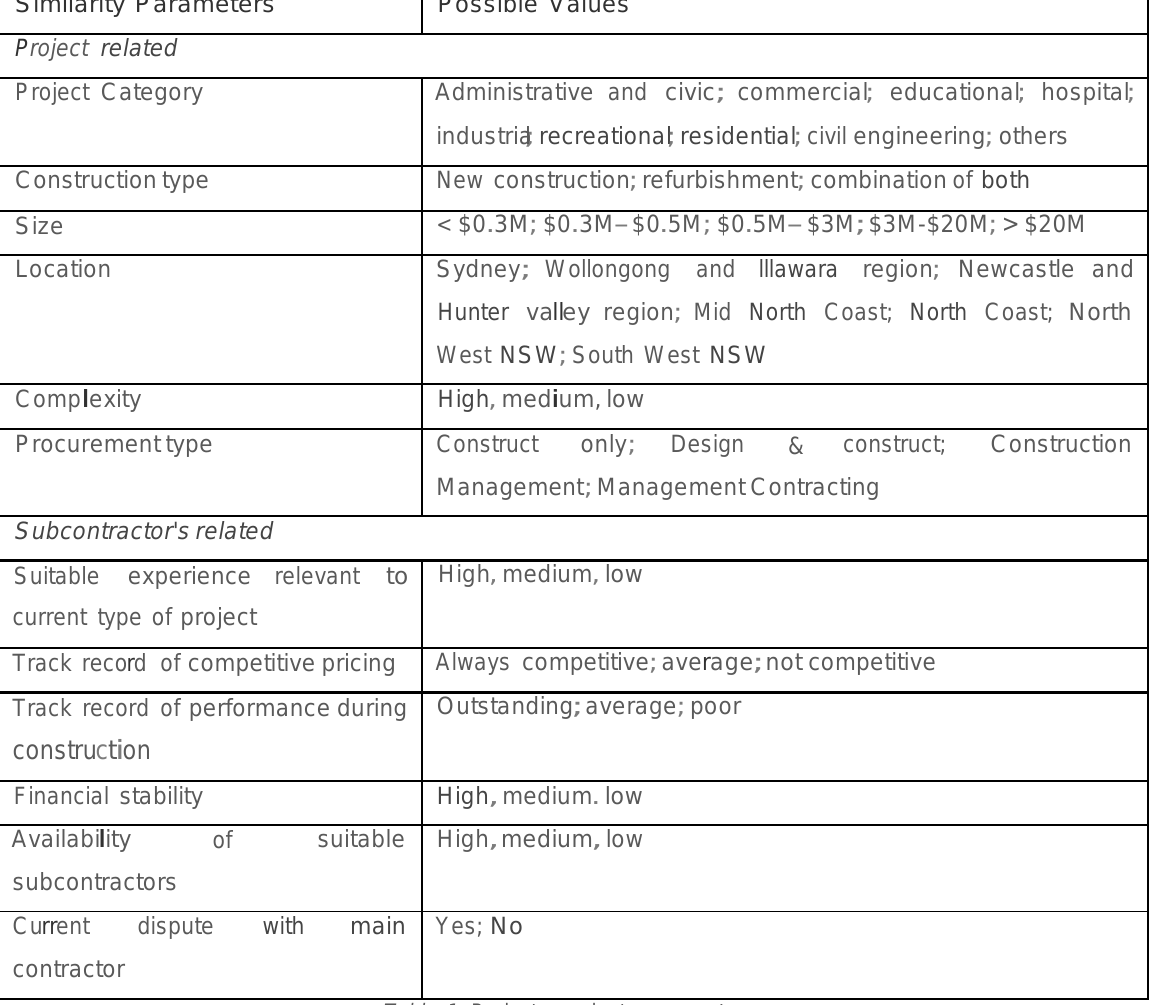
Table 1: Project srmrlanty